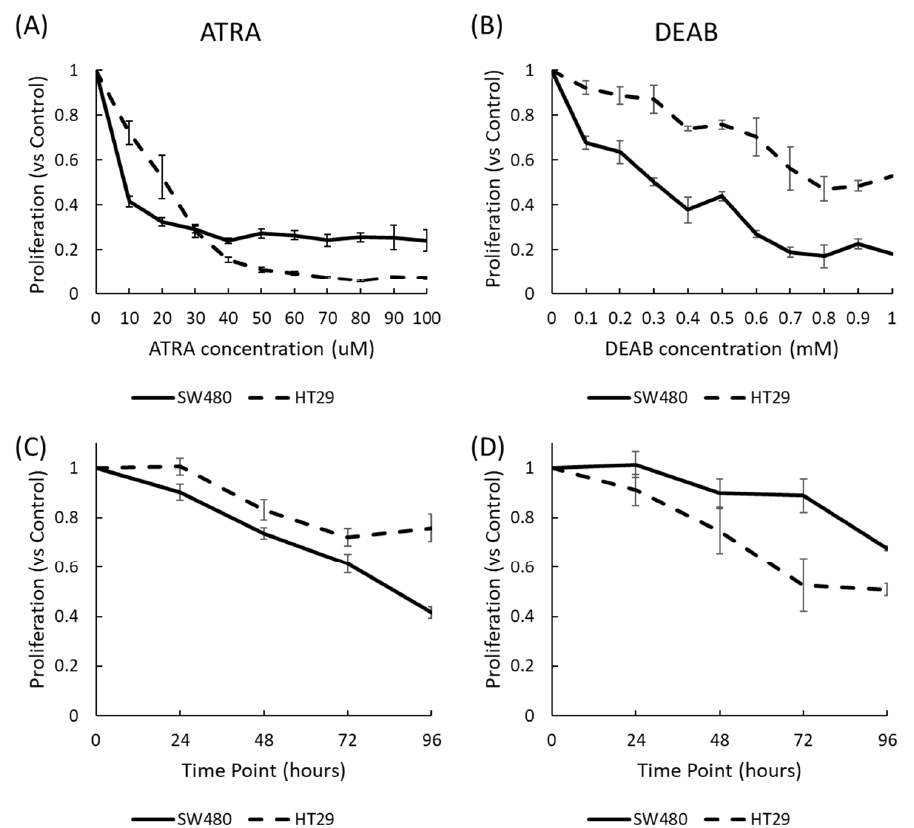
Figure 1. Modulation of RA signaling with ATRA and DEAB decreases CRC cell proliferation. ATRA- ( A ) and DEAB- ( B ) treated cells at varying concentrations at 96 h to determine IC50 values. HT29 and SW480 cells treated for longer times showed reduced rates of proliferation ( C , D ). Vehicle controls were DMSO for ATRA-treated cells and EtOH for DEAB-treated cells.